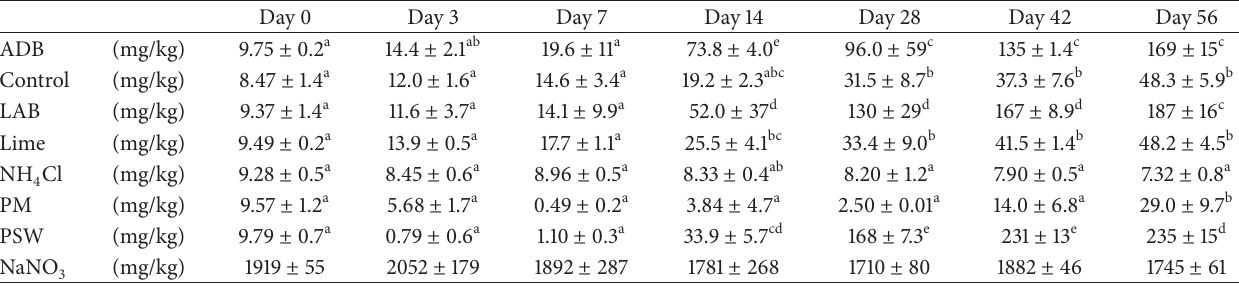
− concentration of treated soils (dry weight) after incubation at 12.5 ∘ C for 56 days. Table 2: NO 3